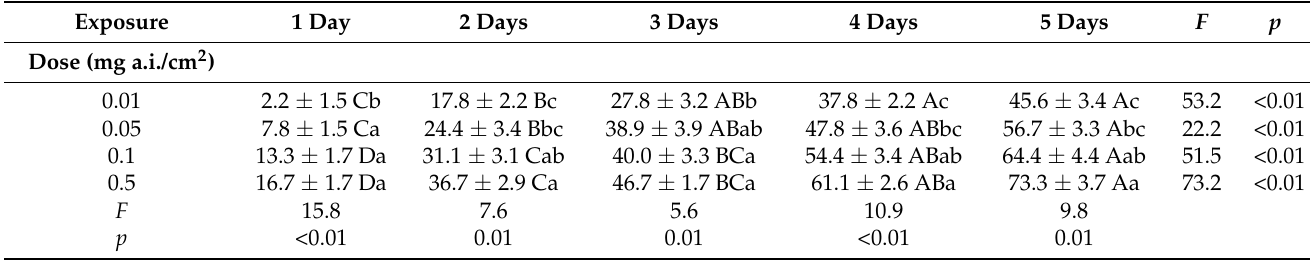
Table 7. Mean immediate mortality (% ± SE) of Acarus siro nymphs exposed on concrete treated with chlorantraniliprole at four doses (0.01, 0.05, 0.1, and 0.5 mg a.i./cm 2 ), for 1, 2, 3, 4, and 5 days. Within each row, means followed by the same uppercase letter are not significantly different (in all cases DF = 4, 44, Tukey–Kramer HSD test at p = 0.05). Within each column, means that are followed by the same lower-case letter are not significantly different (in all cases DF = 3, 35, Tukey–Kramer HSD test at p = 0.05). Where no letters exist, no significant differences were